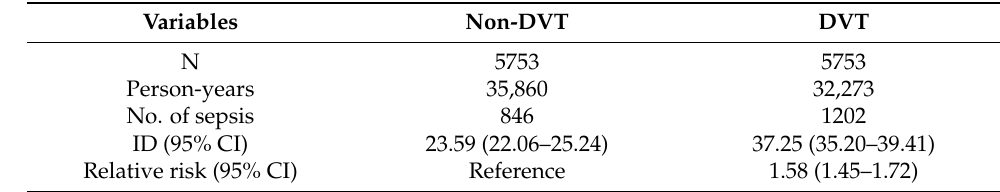
Table 2. Poisson regression of relative risk of DVT and non-DVT